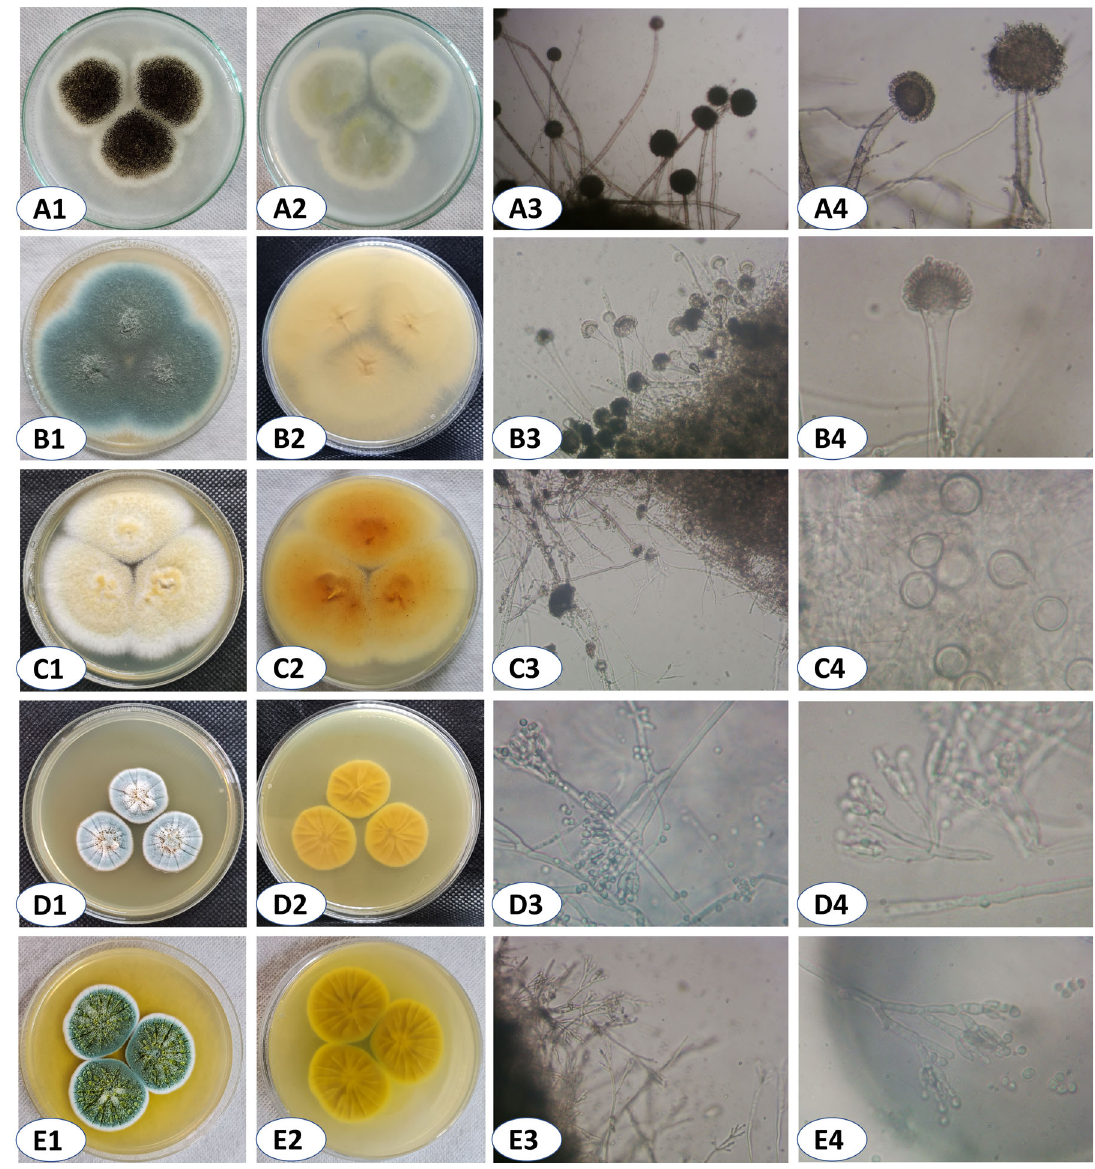
Fig. 7 Morphological and microscopic examination of various fungal strains associated with a historical manuscript (papers and leather bookbinding growing on CYA media). A Is A. niger , B is A. fumigatus; C is A. quadrilineatus; D is P. citrinum , and E is P. chrysogenium . 1 is a fungal colony; 2 is a reverse colony; 3 and 4 are bright fi led microscopes ( X =